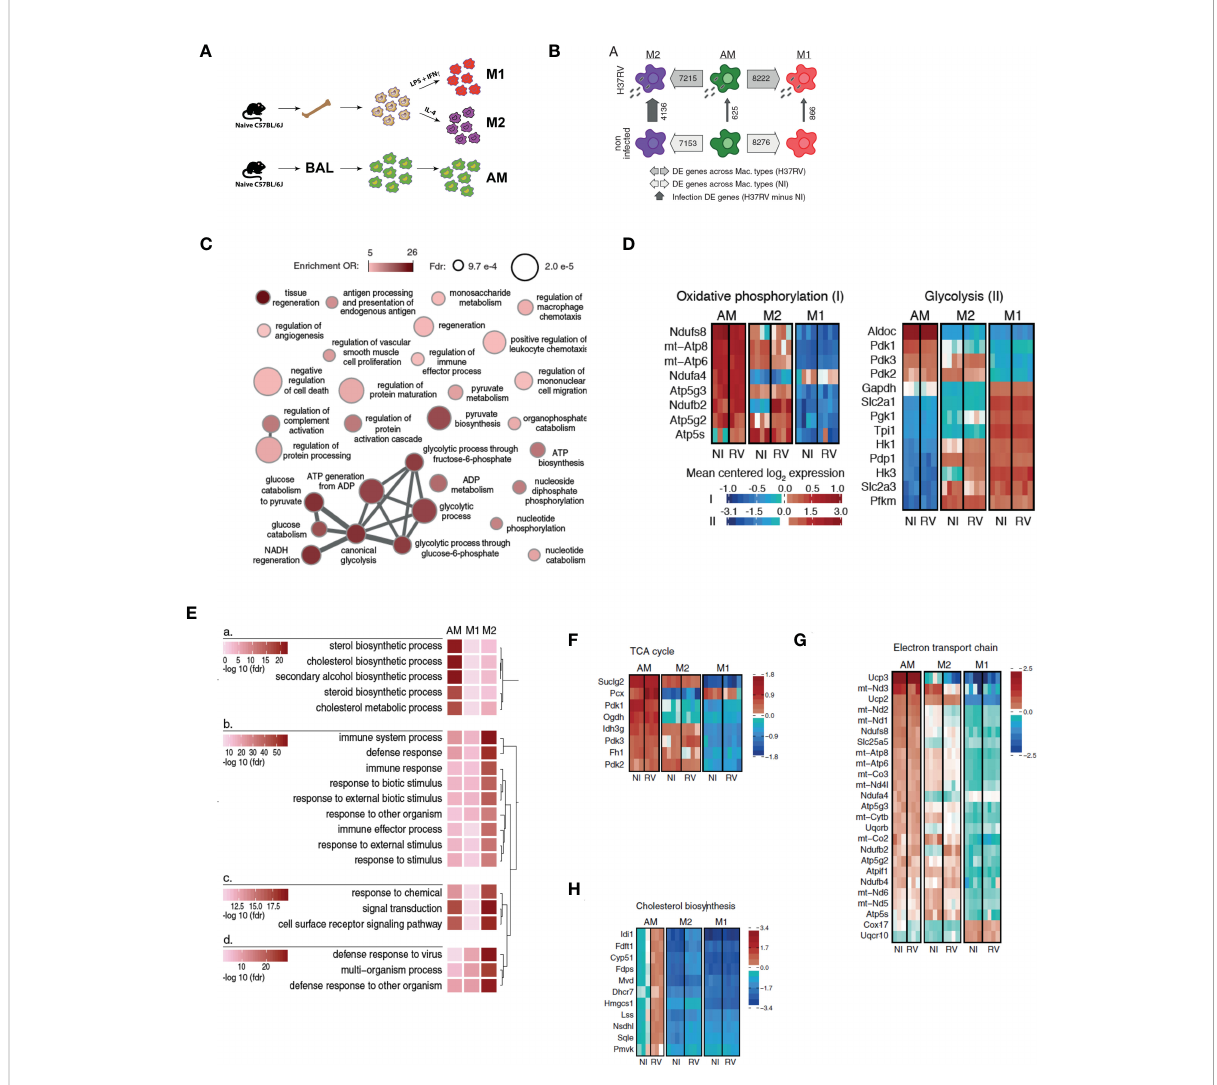
FIGURE 1 Alveolar macrophages have a highly divergent transcriptomic pro fi le with respect to either M1 or M2 macrophages. (A) Bone marrow was harvested from naïve C57BL/6J mice and cultured in the presence of L929-conditioned media for 6 days prior to polarization with either LPS and IFN g (M1), or IL-4 (M2) for 24hrs. Alternatively, alveolar macrophages (AM) were harvested from BAL of naïve mice. Cells were infected with Mtb H37Rv (MOI=1) for 24 hours. (AM n=3 biological replicates, M1/M2 BMDM n=4 biological replicates). (B) Numbers of differentially expressed genes between macrophage types and infection states (at 5% FDR, see also Table S1). (C) Network visualization of the GO terms most signi fi cantly enriched among genes showing a signi fi cantly lower expression in AM than in M1 non-infected macrophages (see also Table S2). Node size is proportional to its statistical signi fi cance (all nodes show an FDR<1x10 -3 ), while color illustrates enrichment ’ s effect size (OR>5) and connections indicate semantic similarity between terms (i.e. genes shared). (D) Expression heatmaps for genes annotated within the metabolic pathways “ Oxidative phosphorylation ” and “ glycolysis ” in www.wikipathways.org. Only genes showing most signi fi cant differential expression changes with respect to any of the contrasts presented in Table S1 were plotted (FDR < 0.05 and abs(logFC)>1). (E) Comparative enrichment results for the GO terms most signi fi cantly enriched among genes up-regulated upon H37RV infection in the three types of macrophages. (F – H) Expression heatmaps for genes annotated within the metabolic pathways “ TCA cycle ” (F) , “ Electron transport chain ” (G) and “ Cholesterol biosynthesis ” (H) in www.wikipathways.org. Only genes showing most signi fi cant differential expression changes with respect to any of the contrasts presented in Table S1 were plotted (FDR < 0.05 and